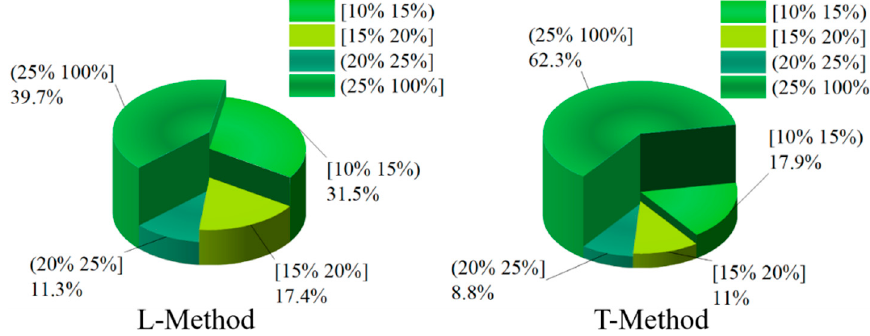
Figure 15. Ratio of left-rear wheel slip under different control strategies.